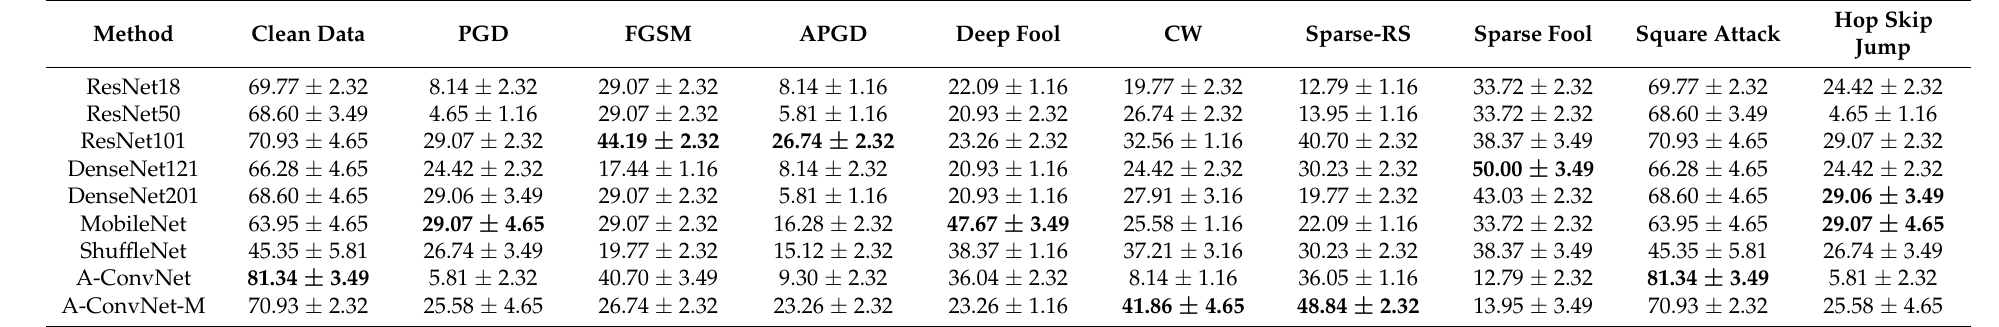
Table 6. Classification accuracy of FUSAR-Ship models against different kinds of adversarial